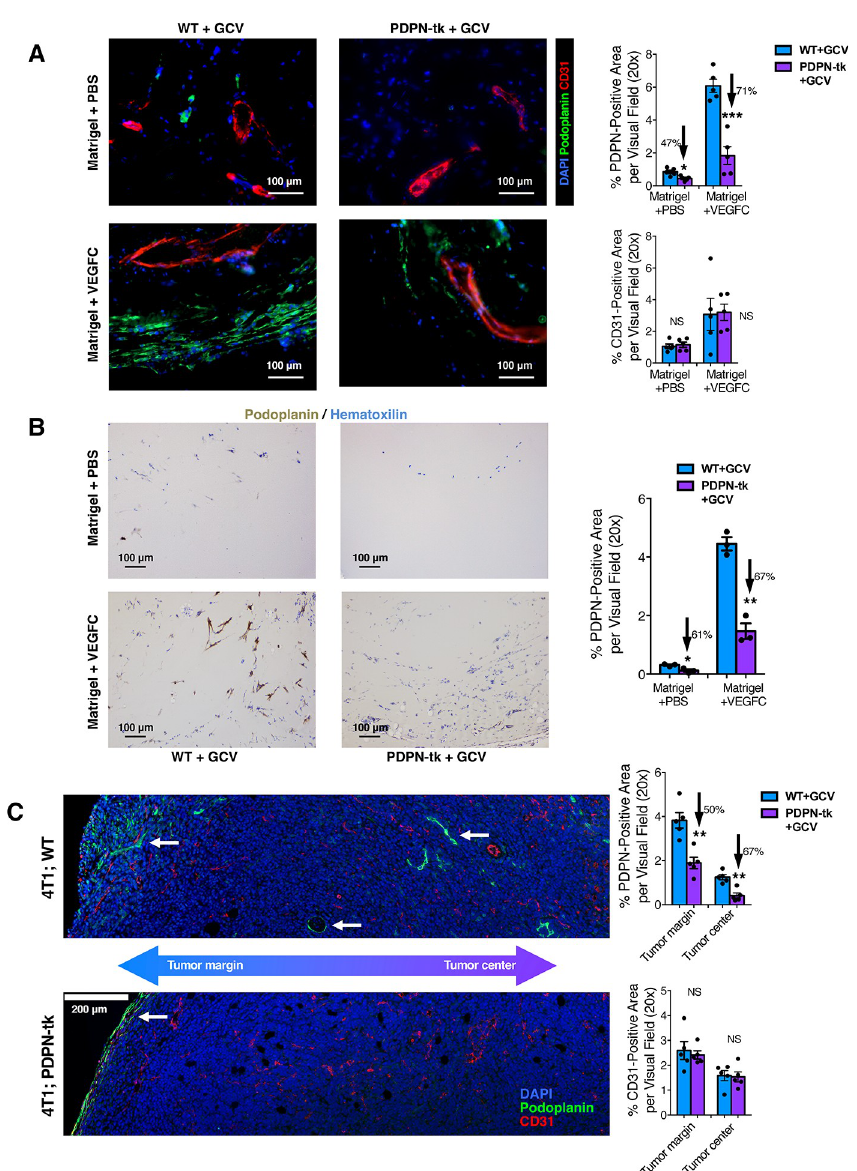
Fig 2. Depletion of proliferating LECs inhibits lymphangiogenesis. (A and B) Lymphangiogenesis and/or angiogenesis in subcutaneously implanted matrigel plugs (growth-factor reduced, supplied with VEGF-C or PBS) from PDPN-tk or WT mice ( n = 5 mice per group). Lymphatic vessel density and blood vessel density was examined by PDPN and CD31 immunofluorescence staining (A). Overall lymphatic vessels density was also evaluated by IHC staining for PDPN (B). Scale bars (A-B), 100 μ m. (C) Orthotopic 4T1 mammary tumors in PDPN-tk or WT mice ( n = 5 female mice per group) examined for lymphatic vessel density (PDPN staining) and blood vessel density (CD31 staining) in both the margin and intratumoral regions of tumors. Scale bar, 200 μ m. GCV treatment was conducted as daily intraperitoneal injections of 50 mg/kg body weight of GCV. The white arrows point to the PDPN-expressing lymphatic vessels. These data are also depicted in S6B Fig. Data are represented as mean ± SEM. Significance is determined using an unpaired two-tailed Student t test ( � p < 0.05, �� p < 0.01, ��� p < 0.001). The underlying data can be found in S1 Data. CD, cluster of differentiation; GCV, ganciclovir; IHC, immunohistochemistry; LEC, lymphatic endothelial cell; NS, not significant; PDPN, podoplanin; tk, thymidine kinase; VEGF-C, vascular endothelial growth factor C; WT, wild